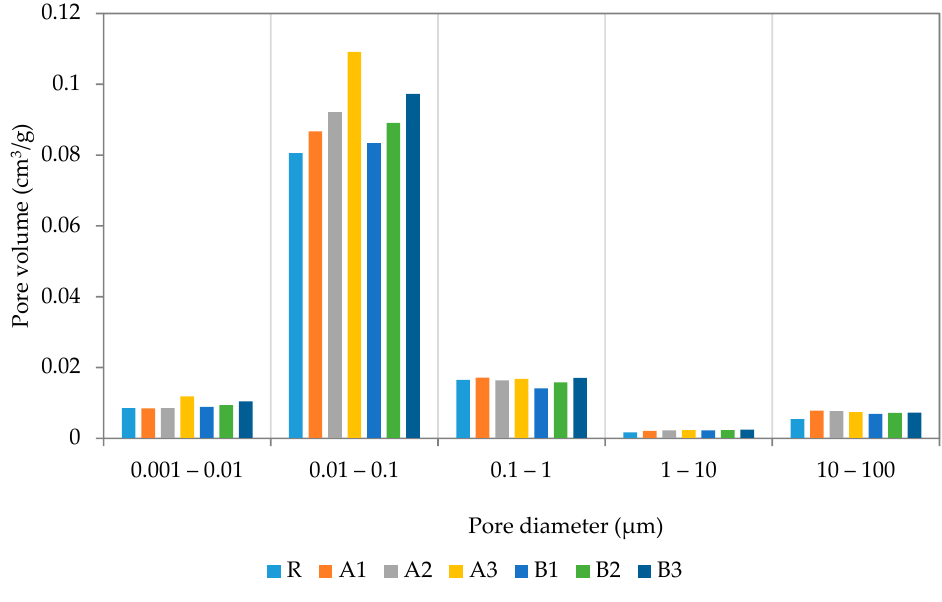
Figure 8. MIP of designed cement mortars at 28 days.